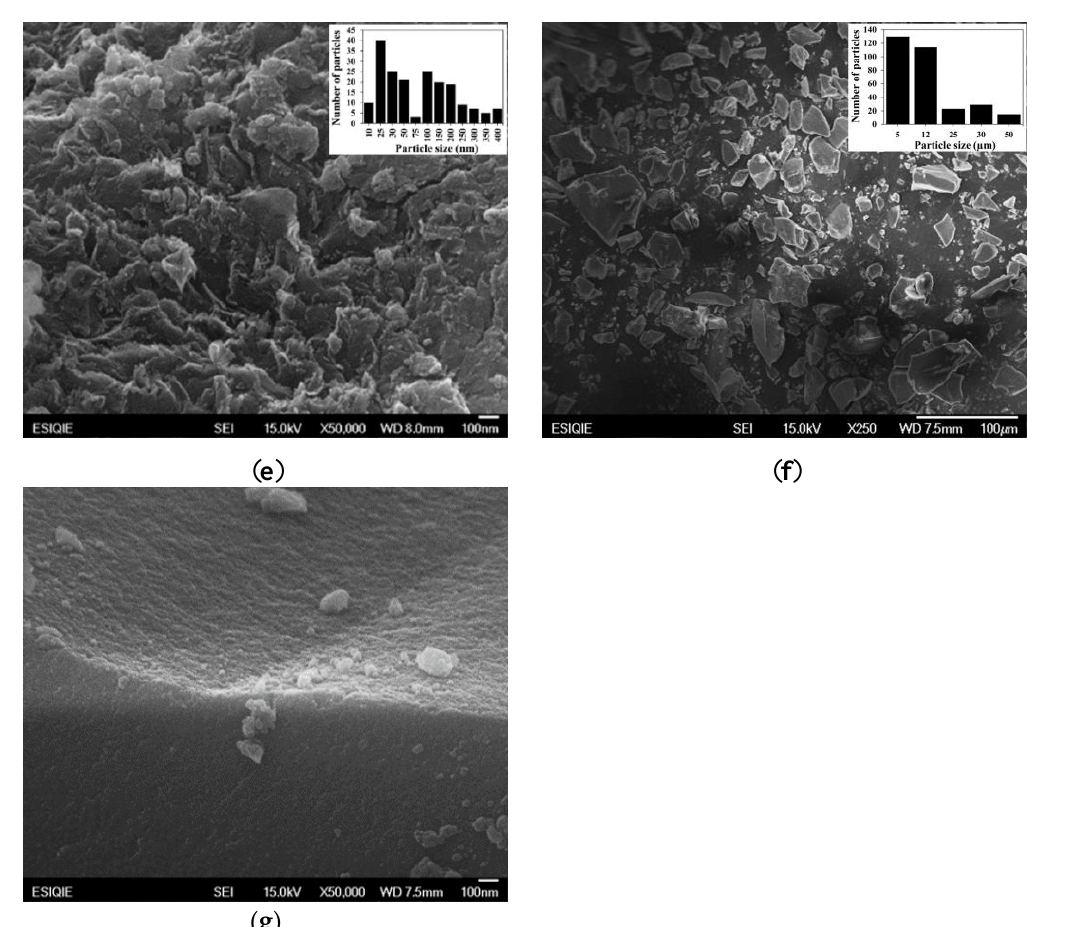
Figure 3. SEM images of SiO 2 ‒Al 2 O 3 oxides calcined at 550 °C: ( a ) 100A, ( b ) 5SA, ( c ) 15SA, ( d ) 20SA, ( e ) 25SA, ( f ) 100S (resolution 100µm), and ( g ) 100S (resolution 100 nm).